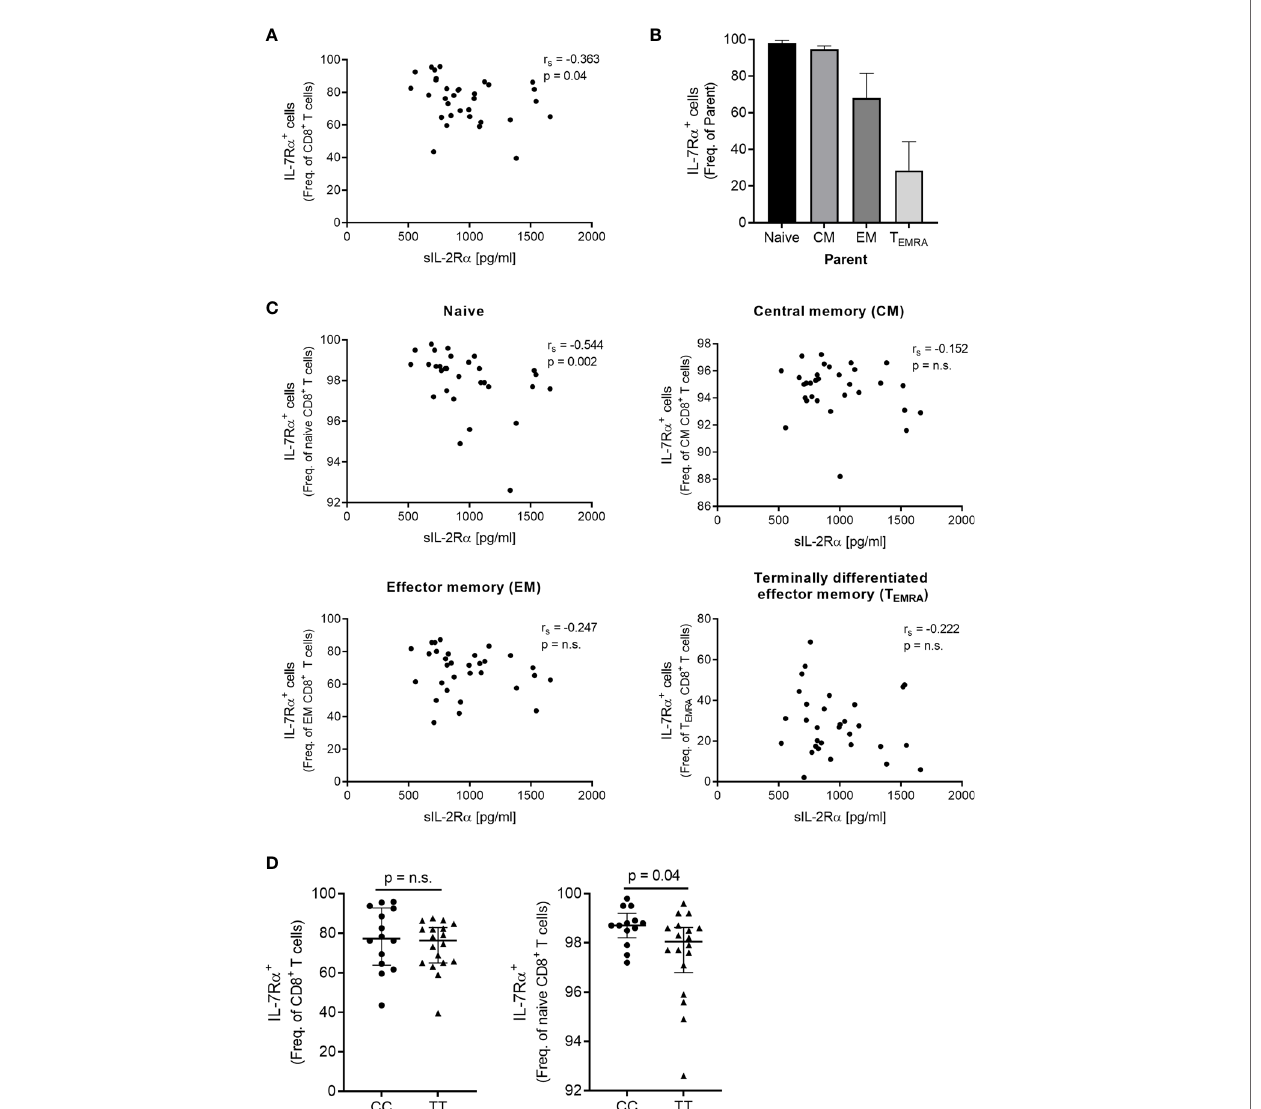
FIGURE 2 | Surface expression of the IL-7R a on CD8 + T cells in relation to sIL-2R a and the MS-associated SNP rs2104286. (A) Spearman correlation between sIL-2R a and frequency (freq.) of IL-7R a + CD8 + T cells in healthy subjects (N = 33). (B) The freq. of IL-7R a + cells on naïve, CM, EM and T EMRA subsets. (C) Spearman correlation between sIL-2R a and the freq. of IL-7R a + naïve (CD45RA hi CCR7 + ) CD8 + T cells, freq. of IL-7R a + central memory (CM, CD45RA - CCR7 + ) CD8 + T cells, freq. of IL-7R a + effector memory (EM, CD45RA - CCR7 - ) CD8 + T cells as well as freq. of IL-7R a + terminal effector memory (T EMRA , CD45RA hi CCR7 - ) CD8 + T cells in healthy subjects (N = 31). Gating strategy is presented in Supplementary Figure 2 . (D) The MS-associated SNP rs2104286 in relation to the freq. of IL-7R a + CD8 + T cells (TT = 18, CC = 14) and the freq. of IL-7R a + naïve CD8 + T cells (TT = 18, CC = 13) in genotype-selected healthy subjects. Genotype comparisons were analysed by a non-parametric Mann-Whitney U test. Error-bars represent median with interquartile range. ns, non-signi fi